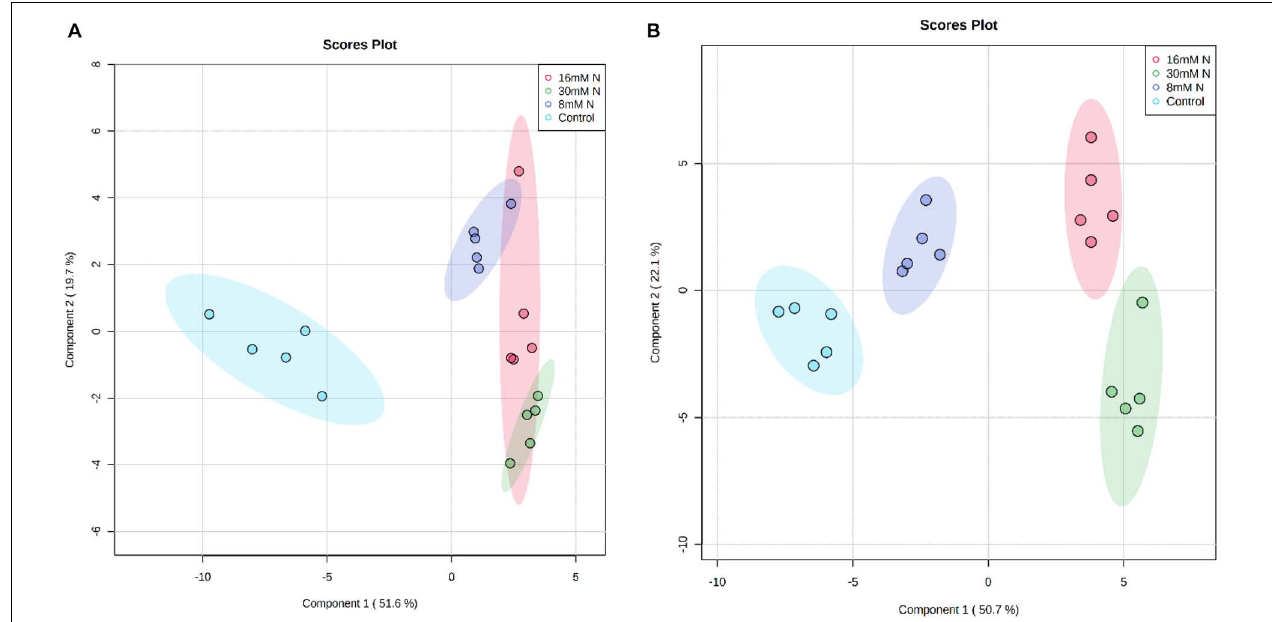
FIGURE 2 | Partial least squares discriminant analysis (PLS-DA) score plot of the first two principal components of the analysis of polar primary metabolites of strawberry cv. Albion (A) and cv. Camarosa (B) exposed to four levels of nitrogen (Green: 30 mM N, Red: 16 mM N, Blue: 8 mM N, and Turquoise: Control). The permutation cross-validation of the PLS-DA model had P = 0.0005 over 2,000 iterations. The ellipse represents a 95% confidence interval, and data points represent biological replicates ( n =